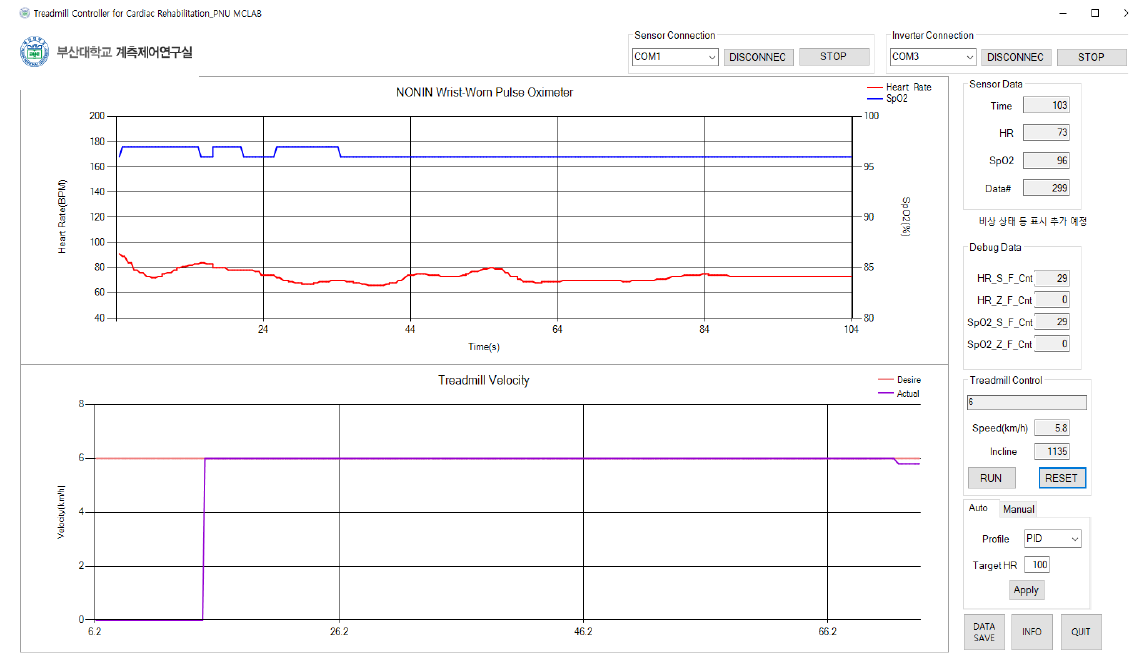
Figure 2. GUI generated using Microsoft Visual Studio. (Korean: Pusan National University, Measurement and Control Lab).